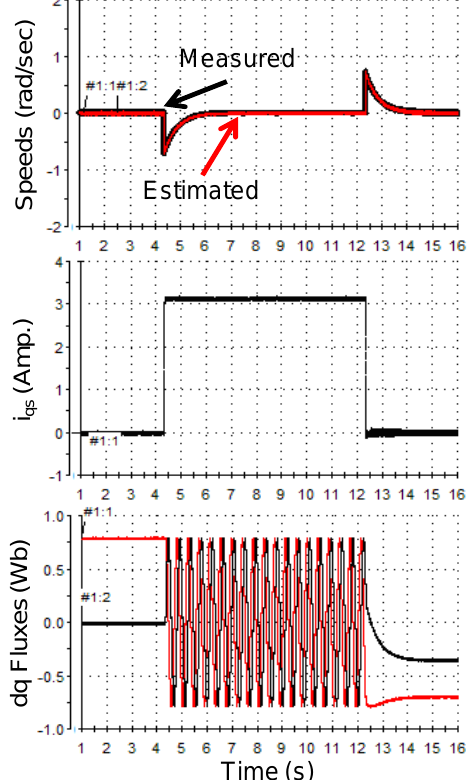
Figure 20. Experimental tests at speed reference of 0 p.u (0 rd/s) with rated load torque change of +7 N.m applied at t = 4.5 s and removed at t = 12